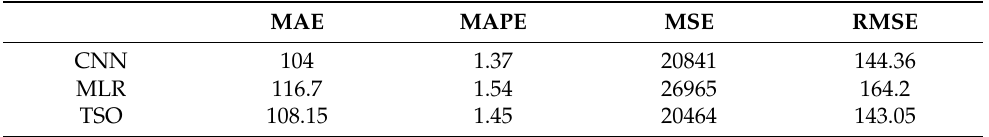
Table 5. Performance evaluation for Convolutional Neural Network (CNN), Multiple Linear Regres- sion (MLR), and Transmission System Operator